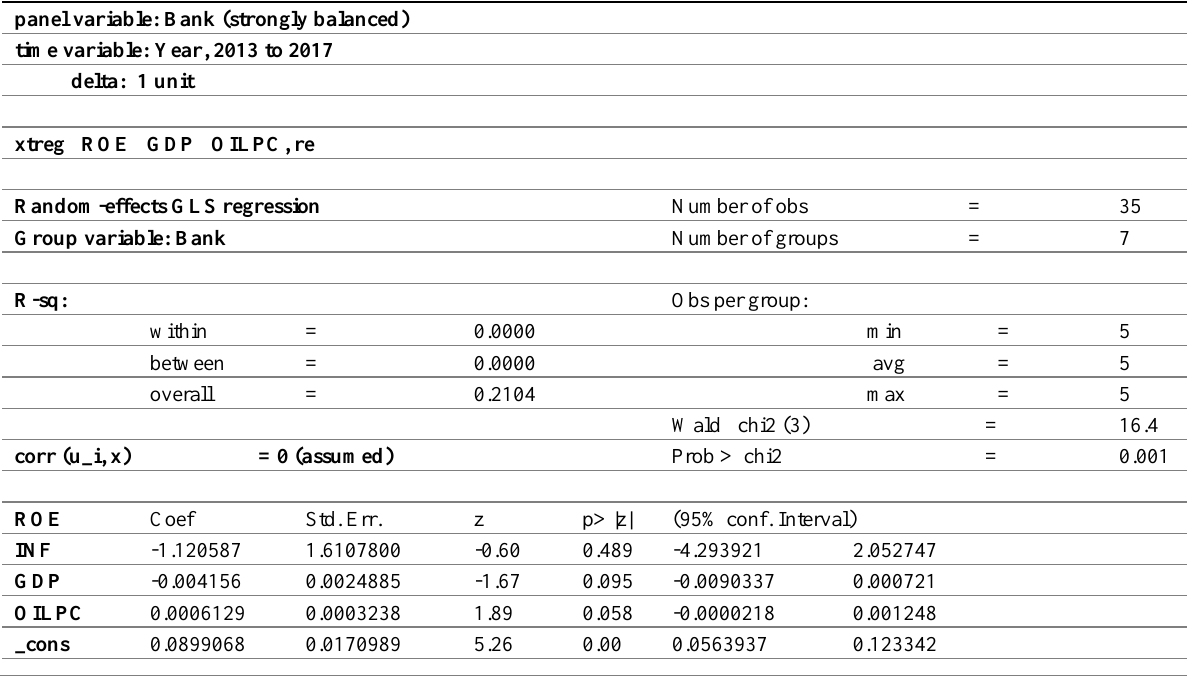
Table 3: Analysis on the Impact of Macroeconomic Factors on